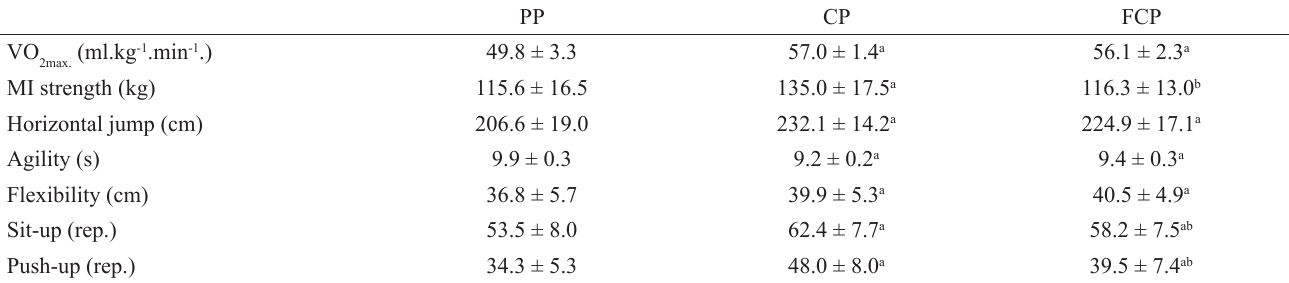
Table 3. Effect of selective loads periodization on physiological and neuromotor characteristics of female futsal players in the beginning of the preparatory (PP), competitive (CP) and final competitive period